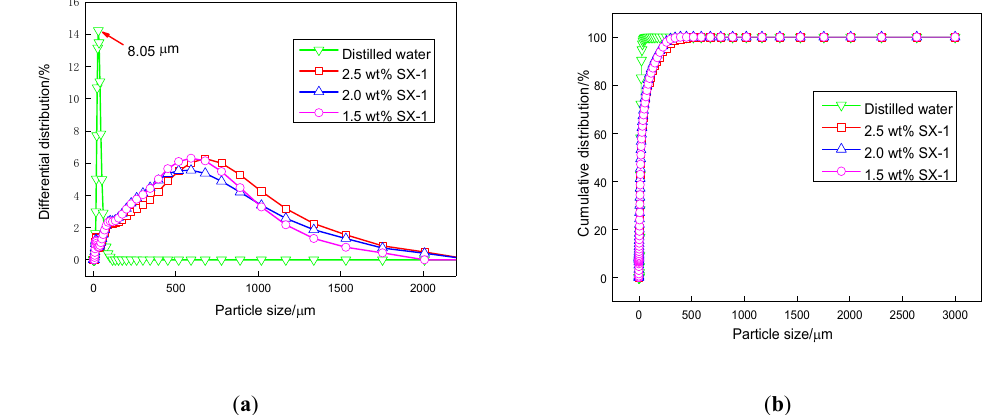
Figure 9. Particle distribution tests of SX-1. ( a ) Differential distribution of samples; ( b ) Cumulative distribution of samples.